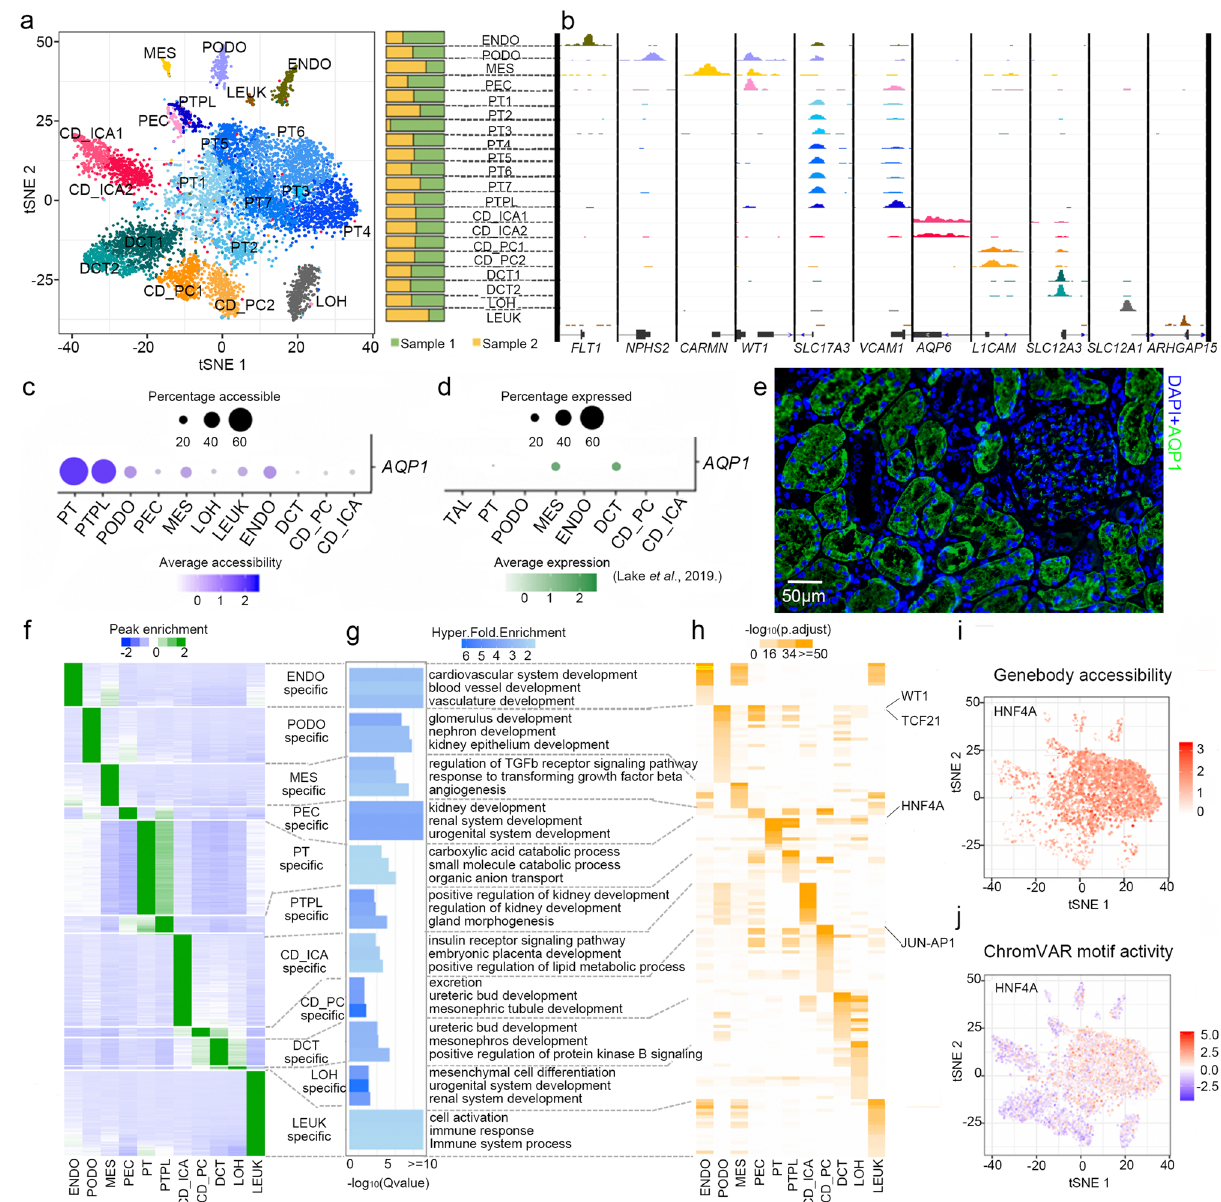
Fig. 1 Single cell chromatin accessibility captures cell type-speci fi c epigenetic features in human kidney. a t-SNE embedding of 9428 kidney cells colored by clustering (left), and the proportions of each cluster in two samples (right). A total of 20 clusters with more than 50 cells were annotated. b Aggregated chromatin accessibility view shows cell type-speci fi c chromatin accessibility at kidney cell type markers. c Genebody accessibility of AQP1 in scATAC-seq. d RNA level of AQP1 in scRNA-seq (Lake et al. 21 ). e Immuno fl uorescence staining of paracancerous kidney tissues con fi rmed PT-speci fi c expression of AQP1 (green) in kidney. Nucleus was stained with DAPI (blue). Data is from one experiment representative of three independent samples examined. f K-means clustering of 19,409 cell type-speci fi c peaks with each cell type showing speci fi c accessible regions. Each row represents a cell type- speci fi c peak, and each column represents an individual cell type. g Enriched GO terms for cell type-speci fi c peaks. Top three biological processes in each cell type are shown. h Heatmap of motif enrichment on cell type-speci fi c peaks for each cell type. Each row represents a transcription factor motif and each column represents an individual cell type. Only motifs with -log10(p.adjust) > 10 in at least one cell type are shown. t-SNE of genebody accessibility ( i ) and chromVAR motif activity ( j ) of HNF4A in scATAC-seq show PT-speci fi c expression and function of HNF4A. Source data are provided as a Source Data fi